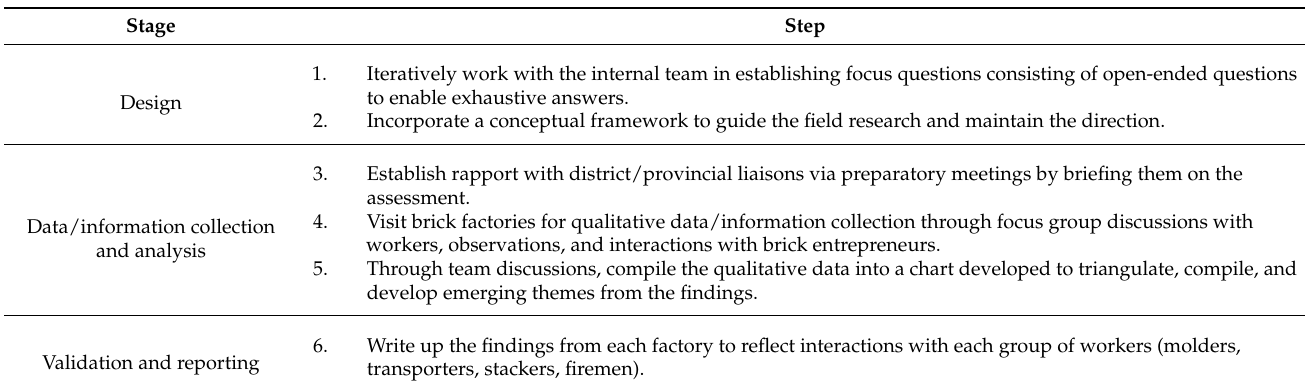
Table 1. Steps in the rapid needs assessment process.